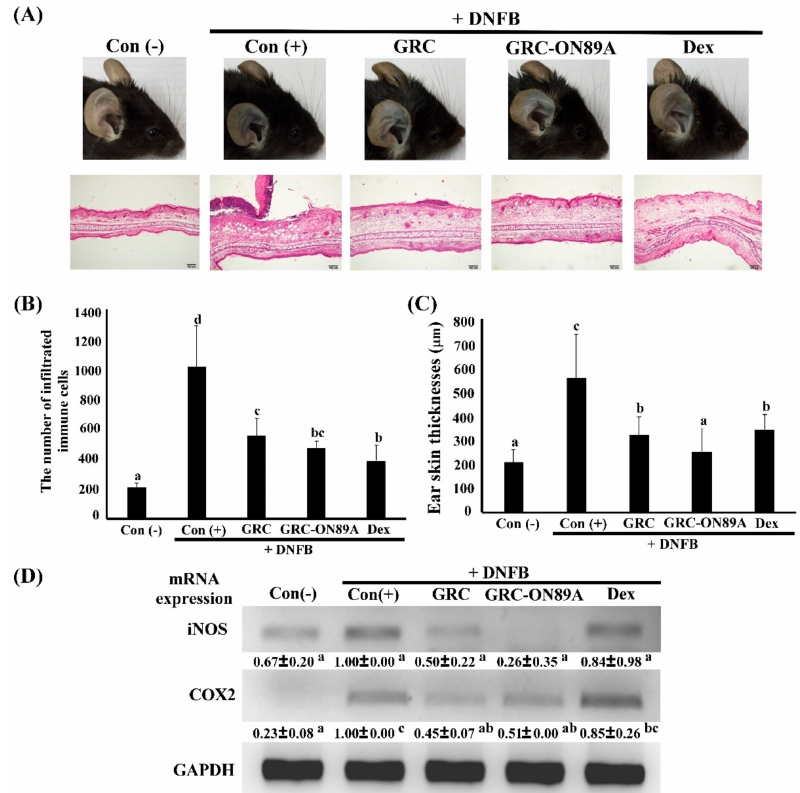
Figure 6. Effect of Cordyceps militaris grown on germinated Rhynchosia nulubilis (GRC) fermented with Pediococcus pentosaceus ON89A isolated from onion (GRC-ON89A) extracts on ear swelling and histopathological changes in 1-fluoro-2, 4-dinitrofluorobenzene (DNFB)-induced contact dermatitis in mice. ( A ) Representative images and histopathological analysis of GRC-ON89A treatment in DNFB-induced allergic contact dermatitis (ACD) in BALB/c mice. Extravasated Evans blue dye was observed in ears of mice. Ear tissue was stained using hematoxylin and eosin. Scale bars = 100 µ m. ( B ) The number of infiltrated immune cells and ( C ) ear thickness of right ear were analyzed using a microscope with Metamorph software (Universal Imaging, West Chester, PA, USA). Data are expressed as means ± standard error (SE) of independent experiments ( n ≥ 3, p < 0.05). ( D ) Effects of GRC-ON89A on iNOS and COX-2 mRNA expression in DNFB-induced contact dermatitis in ear of mice. Data are expressed as means ± SD of independent experiments ( n ≥ 3, p < 0.05). One-way analysis of variance (ANOVA) was used for comparison of group means, followed by Duncan t -test. Different letters indicated that the differences between the groups are significant at p <